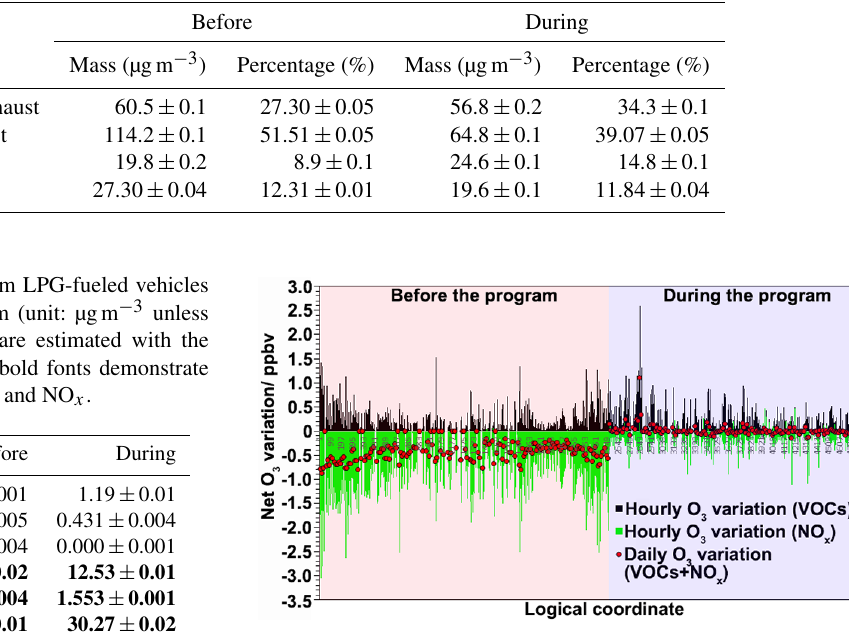
Figure 8. Net O 3 variation as a function of VOCs, NO x and VOCs + NO x emitted from LPG-fueled